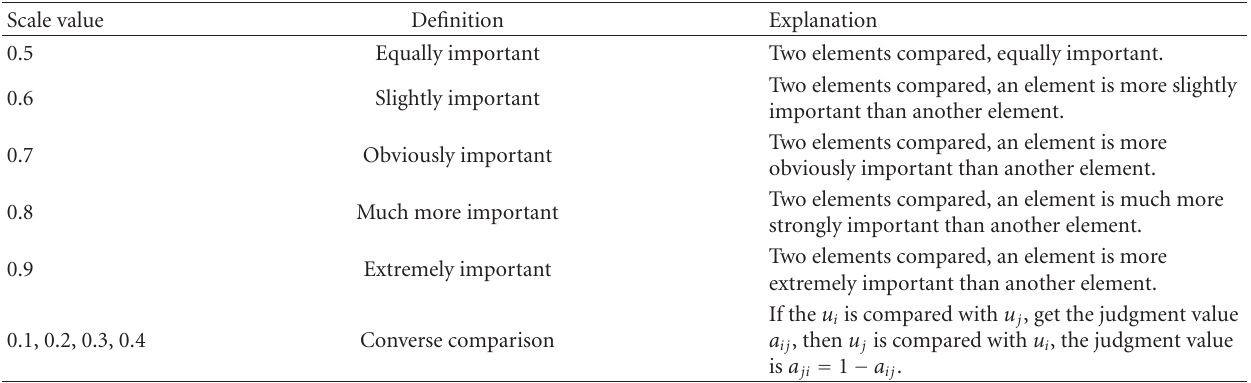
Table 1: The quantity scale of 0 . 1 ∼ 0 . 9.